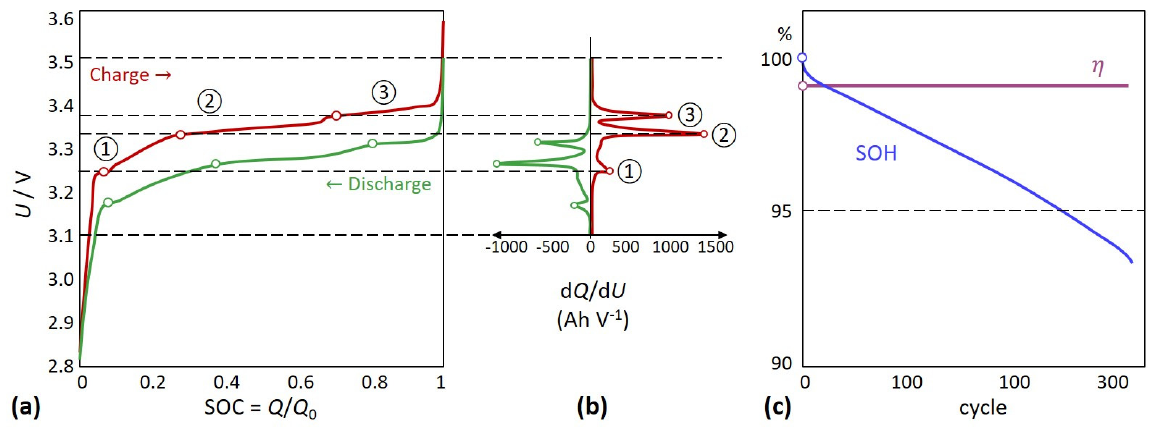
Figure 2. General procedure for the evaluation of long-term measurements: ( a ) A single charge– discharge cycle of a LiFePO 4 battery, ( b ) calculated differential capacity d Q /d U , ( c ) state-of-health and coulombic efficiency η as a function of cycle life. Sections ①②③ correspond to each other.